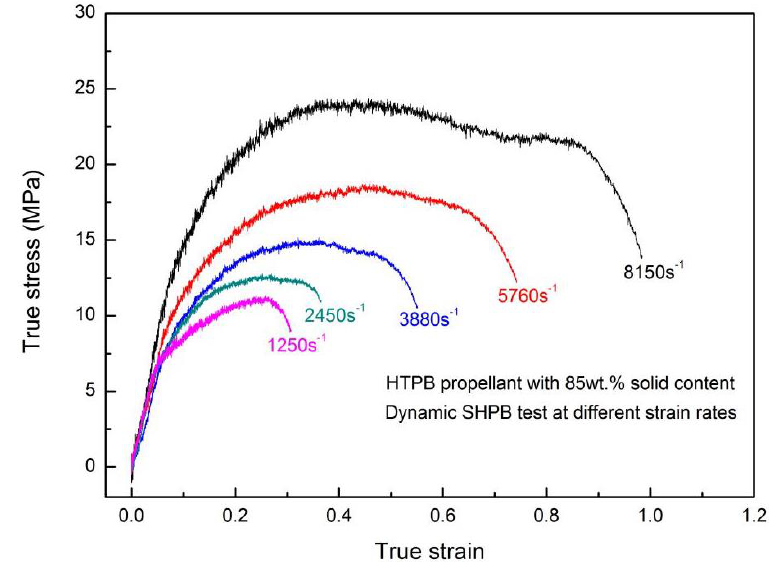
Figure 11. True stress–strain plots of H-85W under various strain rates.